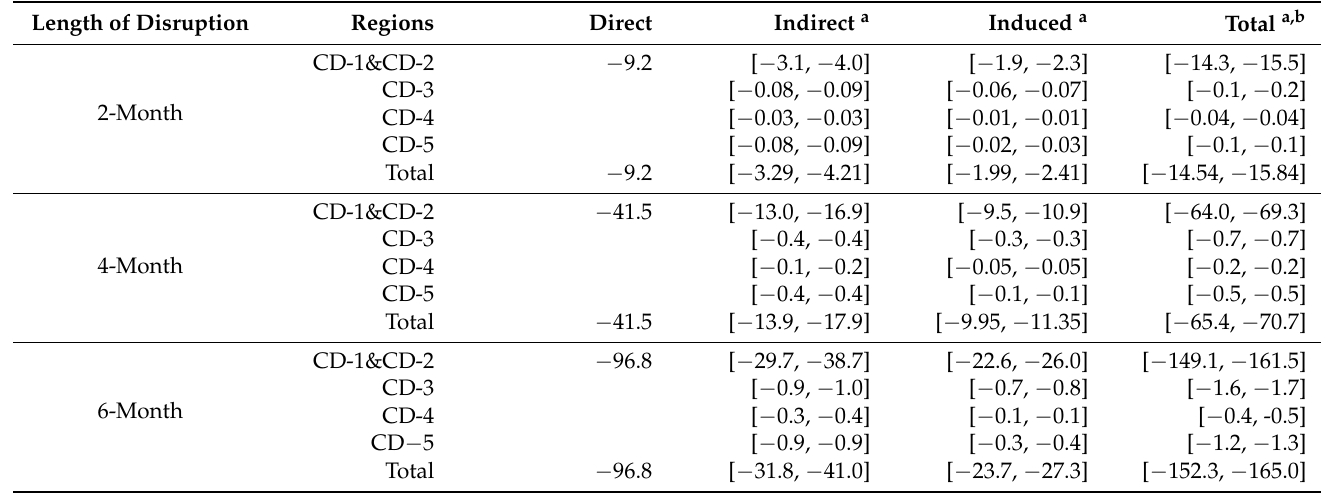
Table 9. Impact on decrease in TIO under different length of water transportation disruption ($